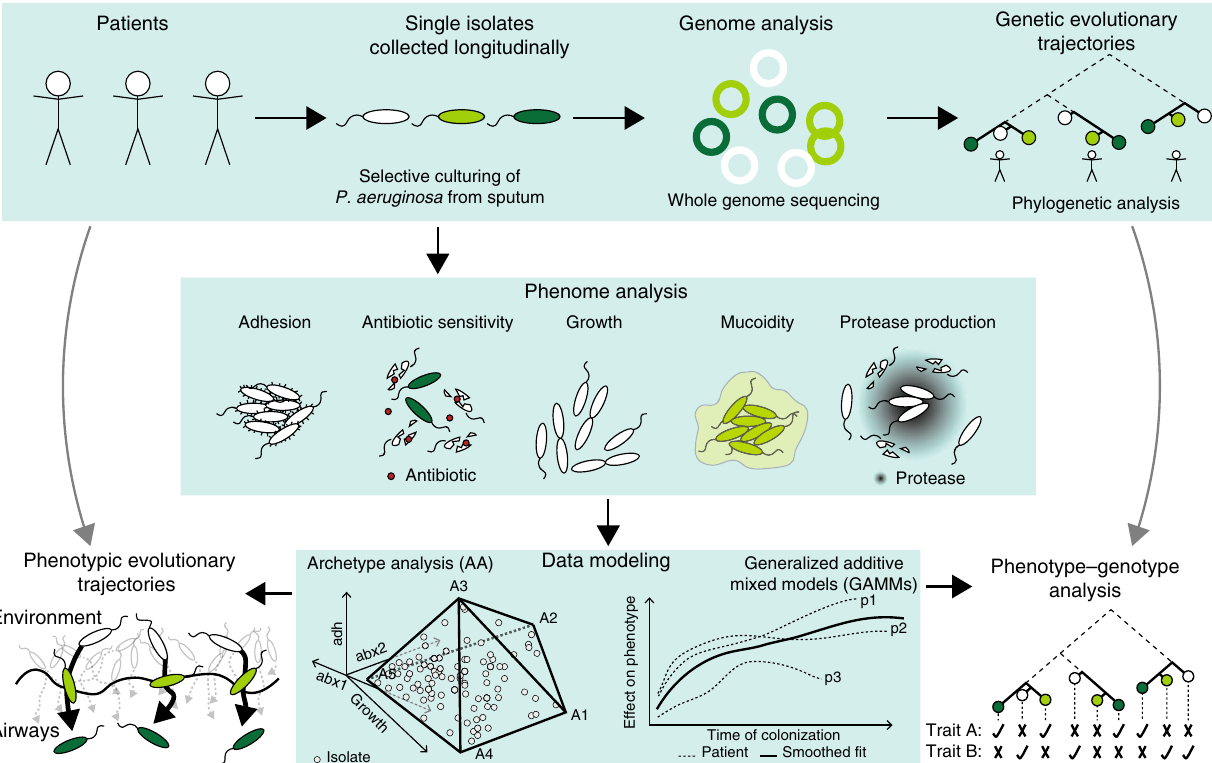
Fig. 1 Study design. Upper panel: Every month, CF patients are seen at the CF clinic at Rigshospitalet in Copenhagen, Denmark. Here they deliver a sputum or endolaryngeal suction sample where selective microbiological culturing is performed 78 . The longitudinally collected isolates have been genome sequenced and analyzed previously 16 . Middle panel: Longitudinally collected isolates have been subjected to different phenotypic analyses for this study and are here (lower panel) analyzed using two data modelling approaches: Archetype analysis (AA) and Generalized Additive Mixed Model (GAMM). By integrating these approaches, we map dominant evolutionary trajectories and analyze mechanistic links between phenotypic and genetic